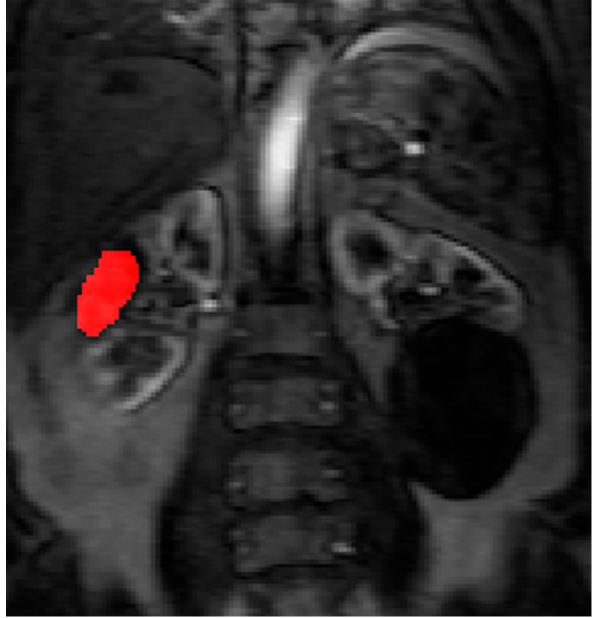
Figure 4. The ROI is drawn on the maximum concentration map generated by PMI software after radiofrequency ablation treatment.